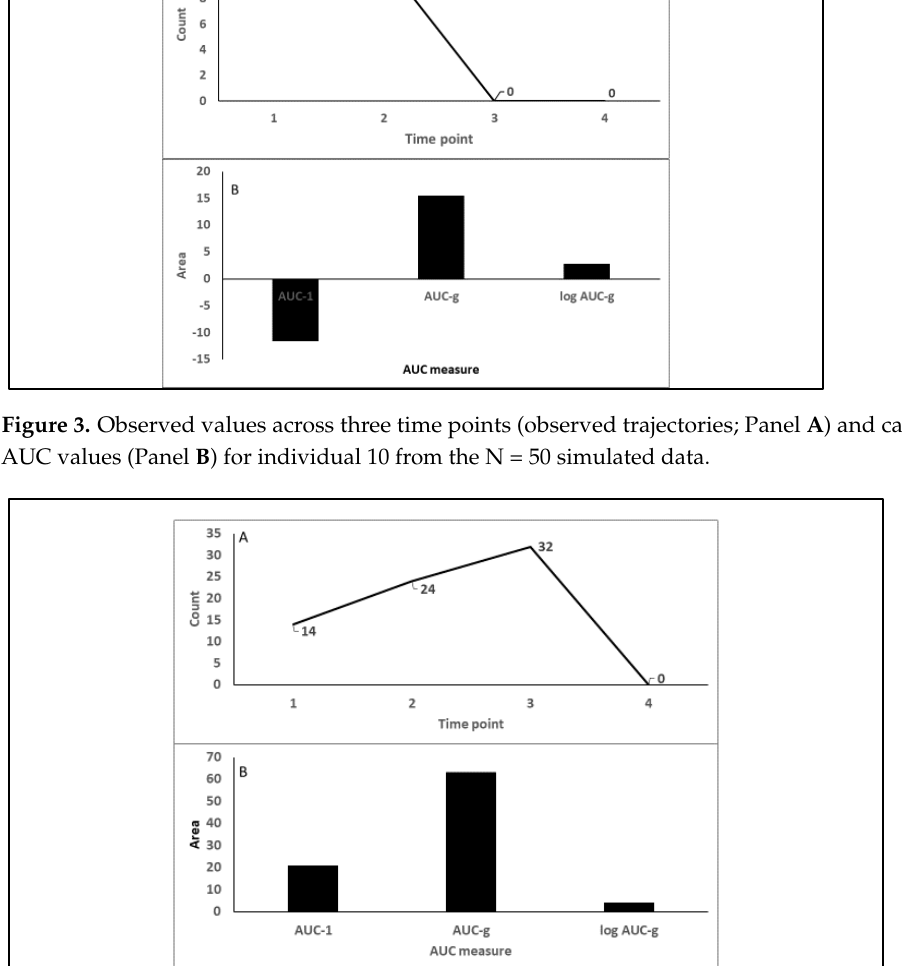
Figure 4. Observed values across three time points (observed trajectories; Panel A ) and calculated AUC values (Panel B ) for individual 18 from the N = 50 simulated data.